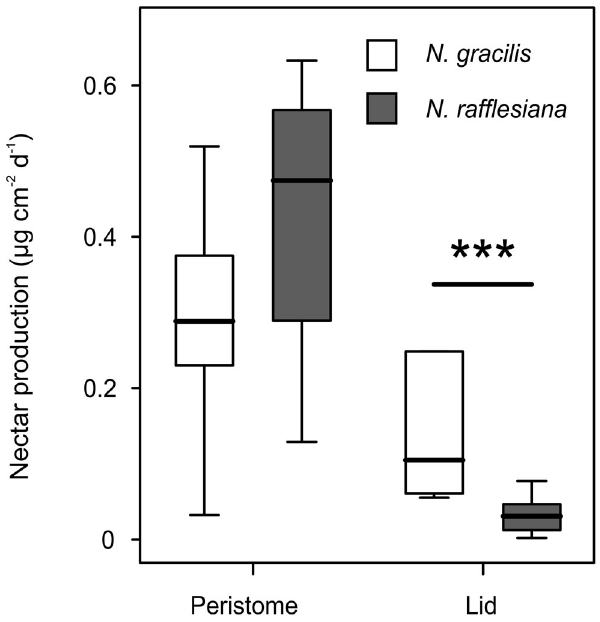
Figure 5. Area-specific nectar secretion onto the peristome and the lower lid surface. N. gracilis pitchers secrete significantly larger amounts of nectar under the lid than those of sympatric N. rafflesiana (***: P ,